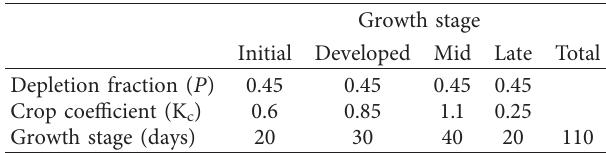
Table 3: Sesame crop parameters used for crop water